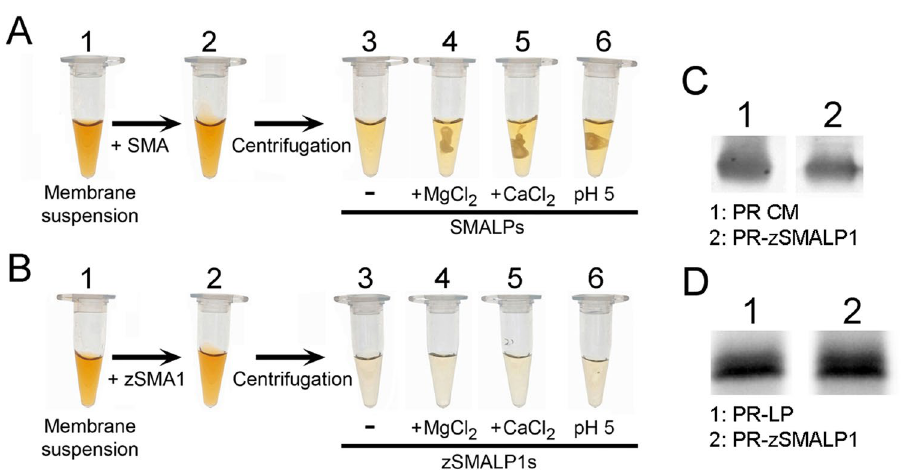
Figure 4. A comparison of buffer compatibility between zSMALP1s and SMALPs. ( A ) SMA nanodiscs (SMALPs). Crude membranes from E. coli expressing recombinant PR (tube 1) were solubilized with SMA (Xiran SL25010-S25; tube 2). The solubilized material obtained after centrifugation was visualized in the absence of buffer changes (tube 3) or after addition of MgCl 2 (tube 4), CaCl 2 (tube 5) or HCl (tube 6). The final concentrations of MgCl 2 and CaCl 2 were 5 mM. The pH in all tubes was 8, except for tube 6 were pH was 5. ( B ) zSMA1 nanodiscs (zSMALP1s). See legend of panel A for details. ( C ) Solubilization of PR from crude membranes. Lane 1 (PR CM): PR in the crude membranes; lane 2 (PR-zSMALP1): PR solubilized into zSMALP1s. Equivalent volumes were loaded. ( D ) Solubilization of purified PR reconstituted into liposomes. Lane 1 (PR-PL): PR reconstituted into liposomes; lane 2 (PR-zSMALP1): PR solubilized into zSMALP1s. The equivalent volume run in lane 2 was twice that run on lane 1. The data correspond to immunoblots using a primary antibody against the His tag fused to the C-terminal end of